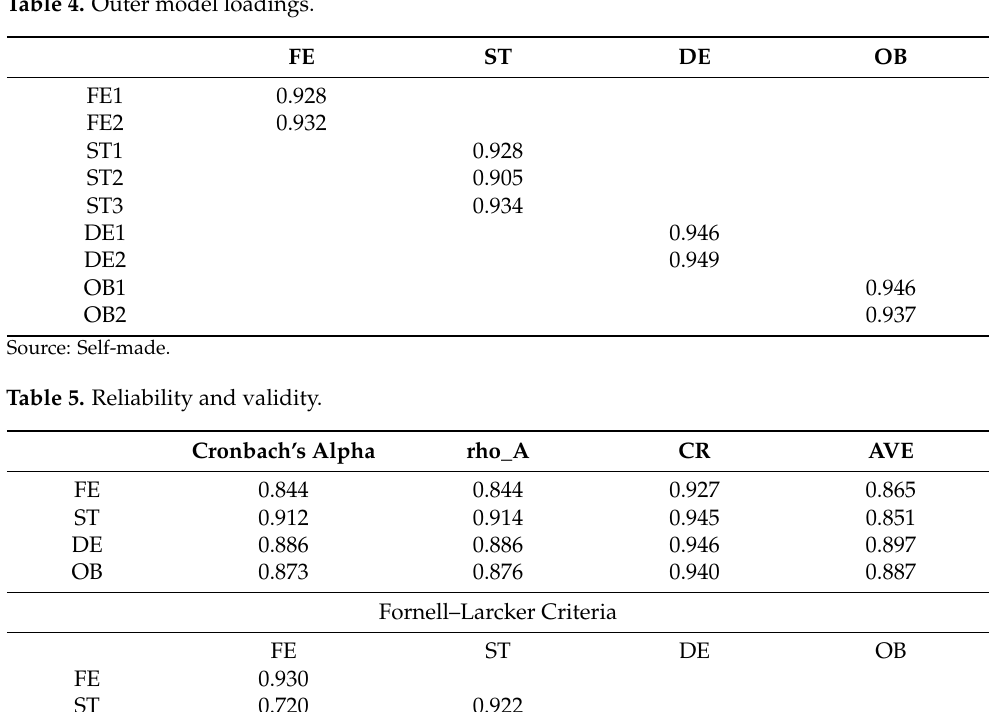
Table 4. Outer model loadings.